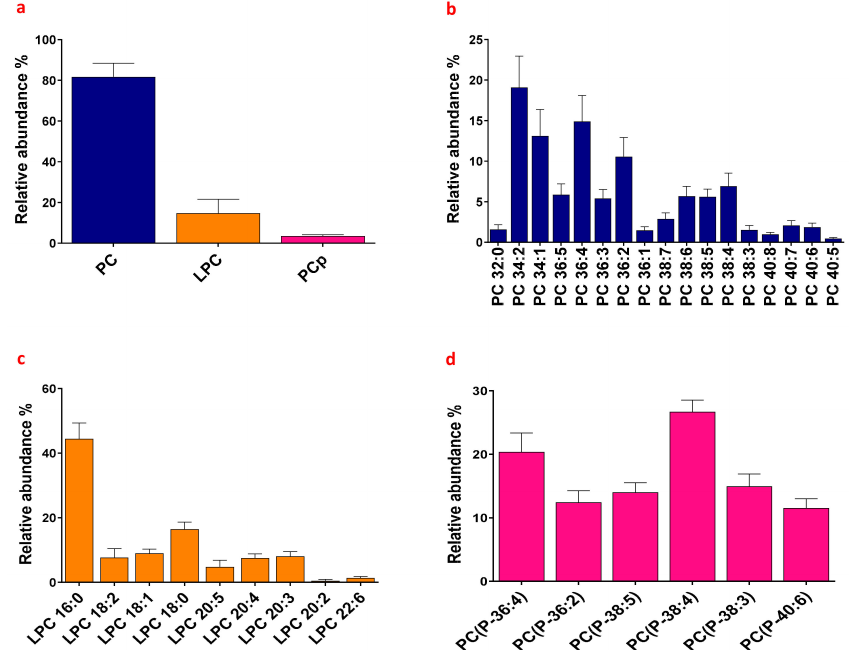
Figure 1. Relative abundances of analyzed lipids in human synovial fluids (HSF) of a cohort of patients suffering from joint pain associated with different rheumatic diseases. Analysis of lipid species in HSF samples was carried out by a direct infusion into mass spectrometry (MS) using an electrospray ionization source (ESI) in positive ion mode. ( a ) Relative abundances of lipid classes (PhosphatidylCholine PC, LysoPhosphatidylCholine LPC and plasmalogen PC PCp). ( b ) Relative abundances of PC species. ( c ) Relative abundances of LPC species showing a high level of LPC 16:0. ( d ) Relative abundances of the different PCp